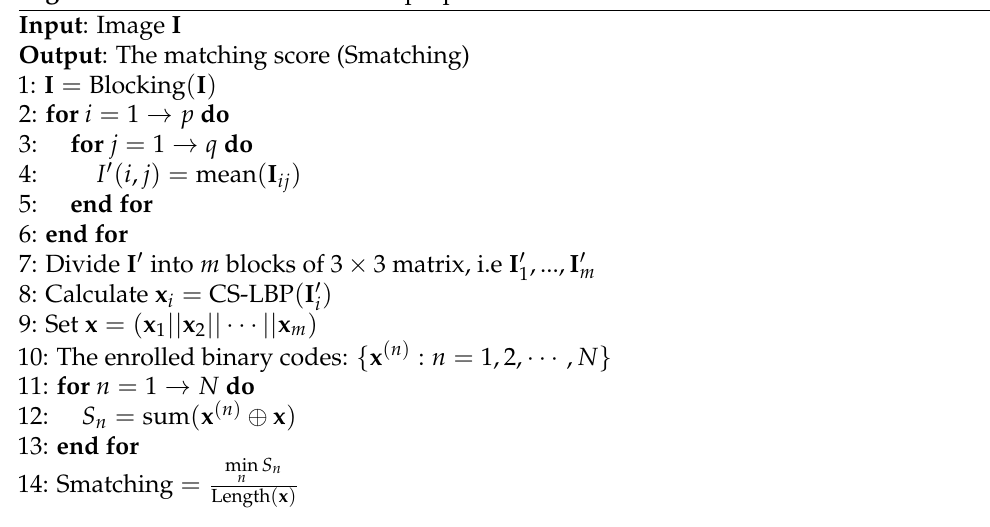
Algorithm 1 The calculation of the proposed